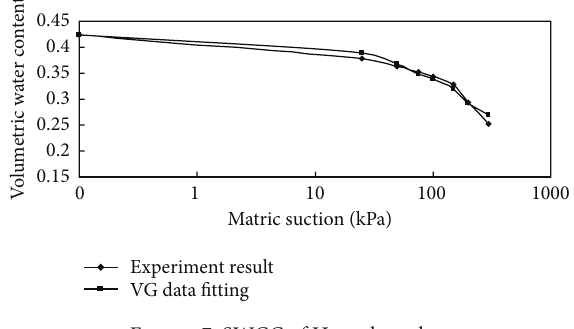
Figure 7: SWCC of Hongshan